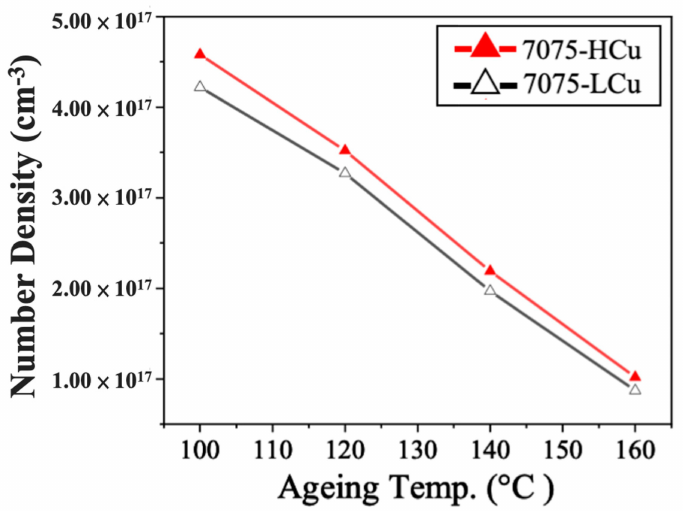
Figure 10. Plot of number density of precipitate versus aging temperature for the two alloys subjected to different PA conditions.